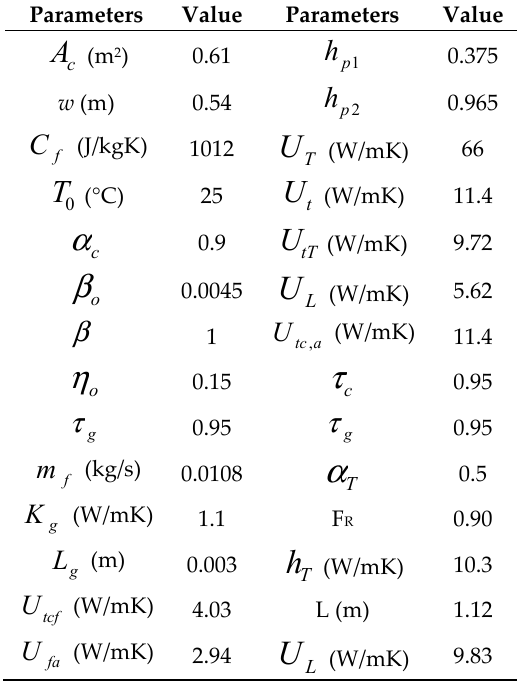
Figure 1. Schematic diagram of conventional PVT system [24–26]. Table 1. Thermal and optical properties of PVT system